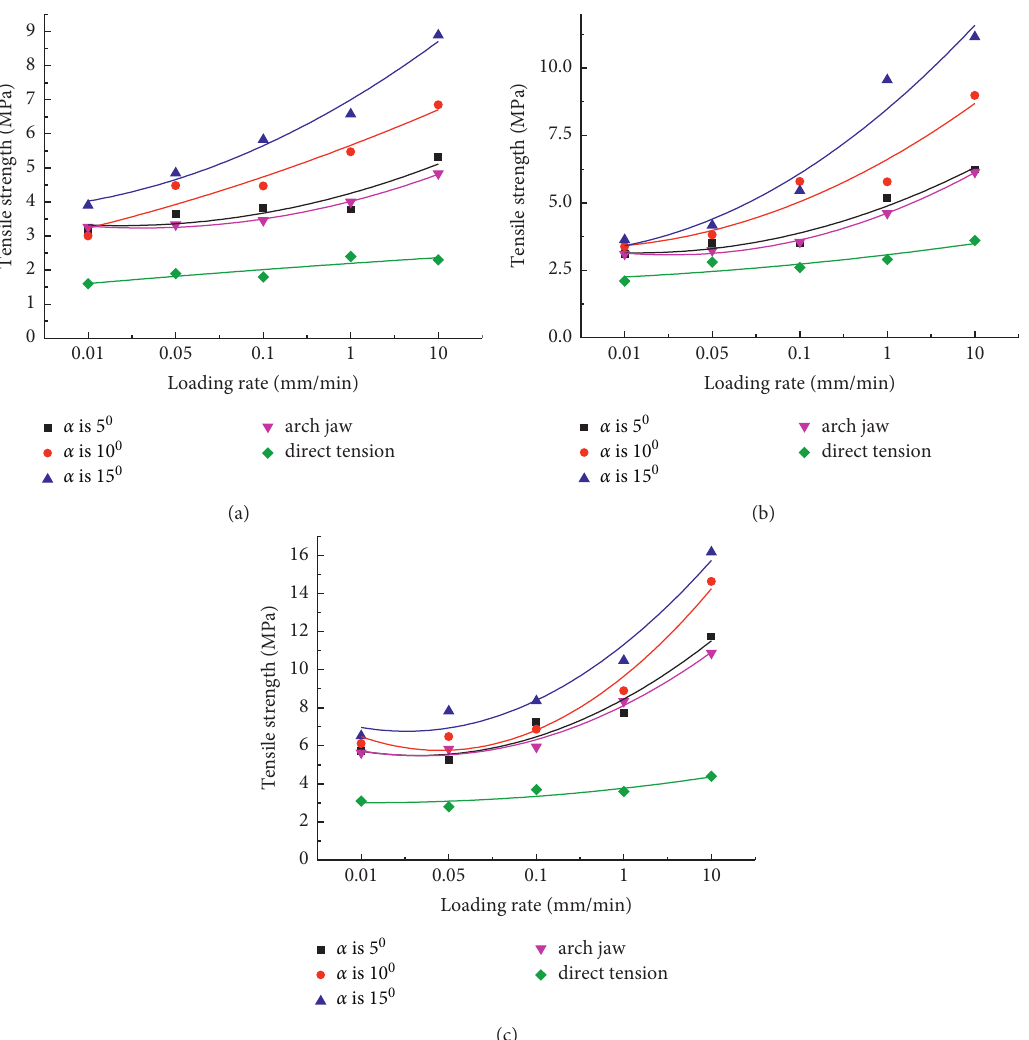
Figure 6: Tensile strengths: (a–c) measured tensile strengths for the sandstone, rust stone, and granite specimens,